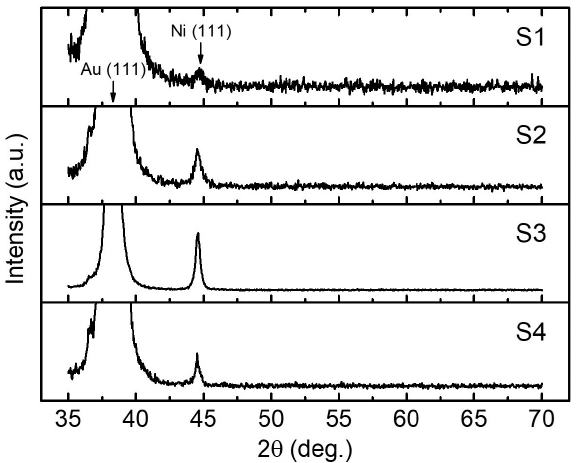
Figure 5. X-ray diffraction (XRD) patterns acquired from the Ni NTs vertically-supported on the Au/Si substrates and prepared by applying (versus SCE) different cathodic reduction potentials for the Cu/Ni core/shell NWs growth: − 0.95 V (S1), − 1.00 V (S2), − 1.05 V (S3) and − 1.10 V